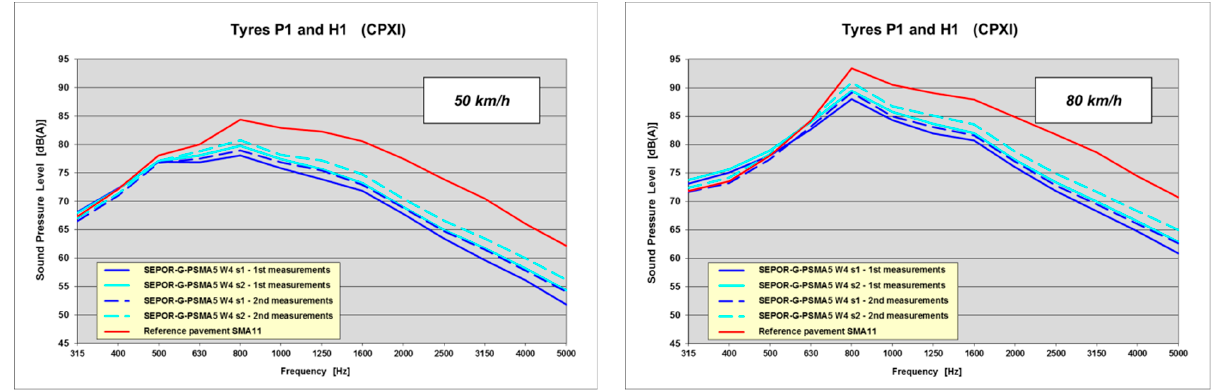
Figure 24. Frequency spectra of poroelastic wearing course placed at the Galaktyczna long test section.